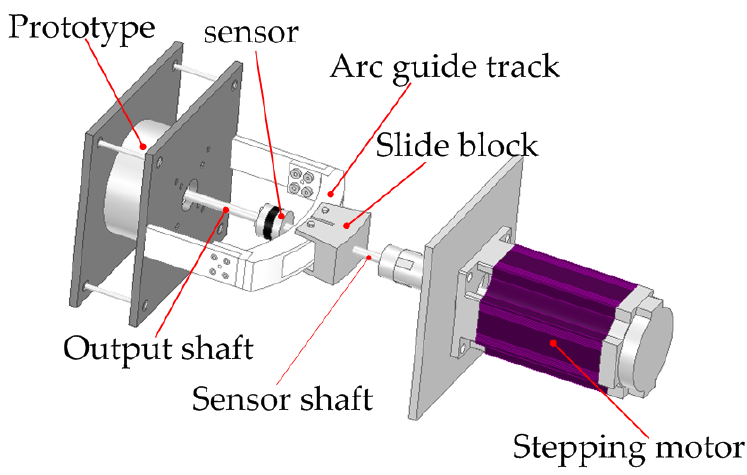
Figure 16. Torque measuring equipment.